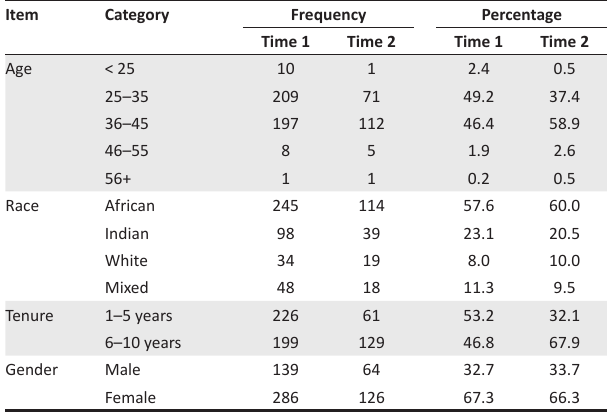
TABLE 1: Characteristics of Time 1 participants and Time 2 participants.